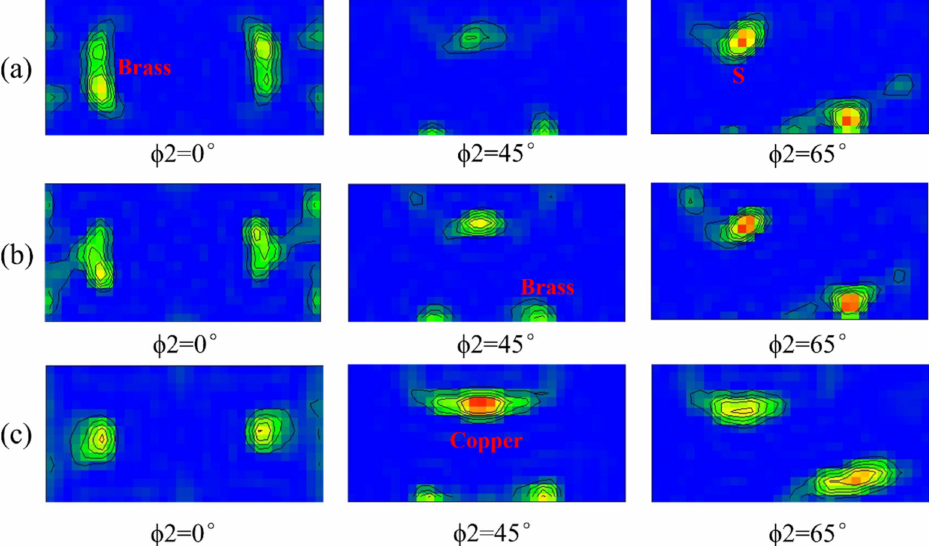
Figure 7. ODF diagrams of samples at different rolling temperatures after aging treatment: S420 ( a ), S450 ( b ), S480 ( c ).